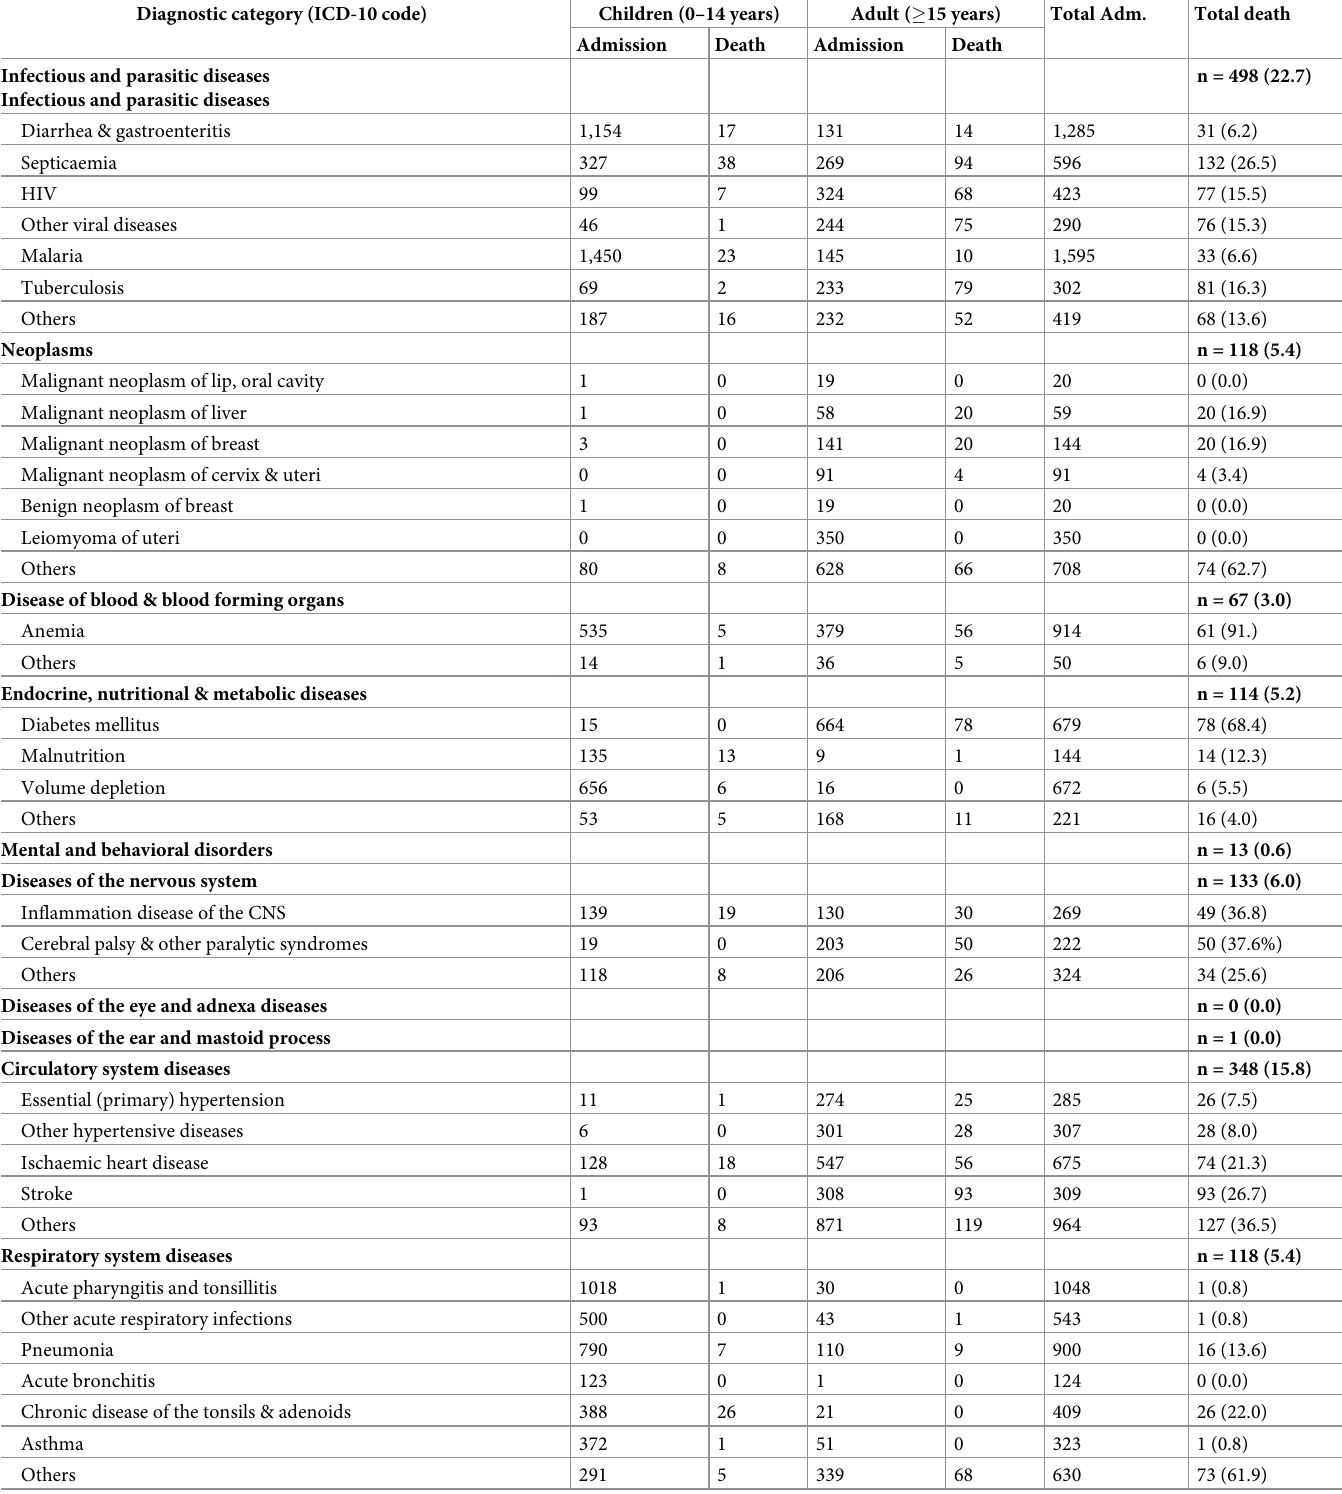
Table 4. Distribution of causes of morbidity and mortality by broad ICD-10 classification and specific disease types. Diagnostic category (ICD-10